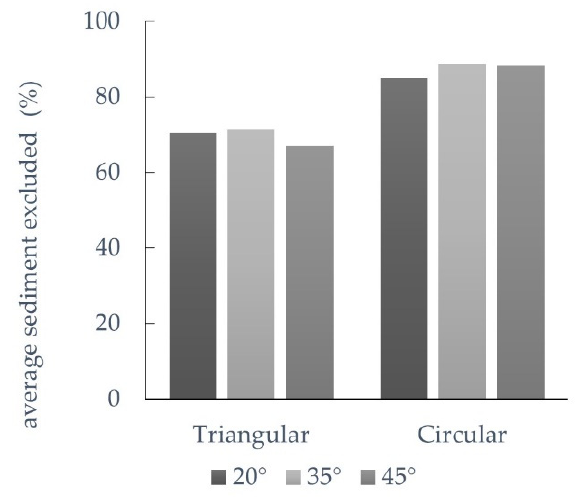
Figure 9. Graph of the average percentage of sediment excluded.